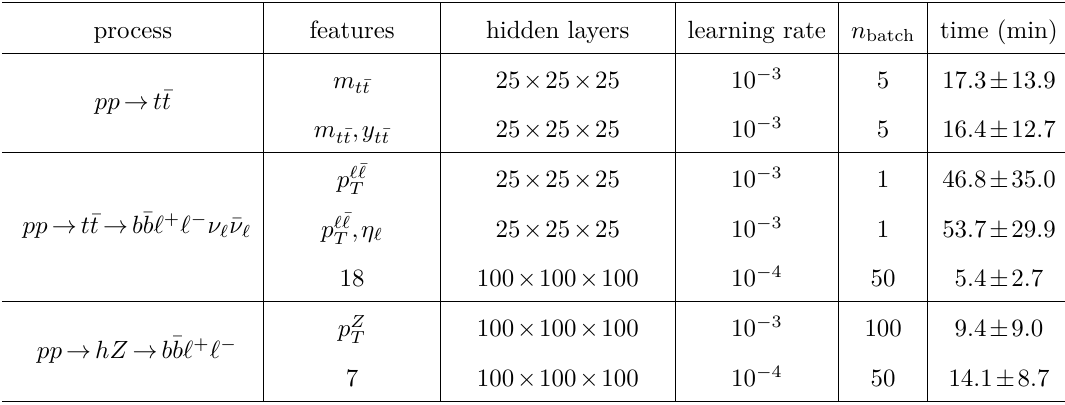
Table 1. Overview of the settings for the neural network trainings. For each of the processes to be described in section 4, we specify the n k kinematic features x used for the likelihood ratio parametrization, the architecture, the learning rate, the number of mini-batches, and the training time per network averaged over all replicas. As indicated by eq. (3.19), given a process for which the parameter space is spanned by n eft Wilson coefficients, there are ( n 2 neural networks to be trained. For each choice of n k kinematic features, these neural networks share the settings listed